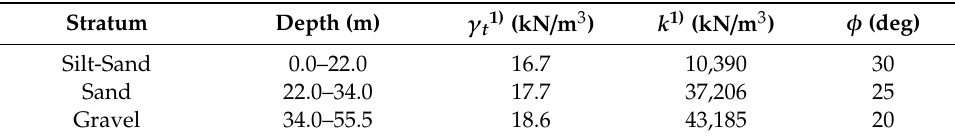
Table 3. Soil strata on o ff shore in Korea.